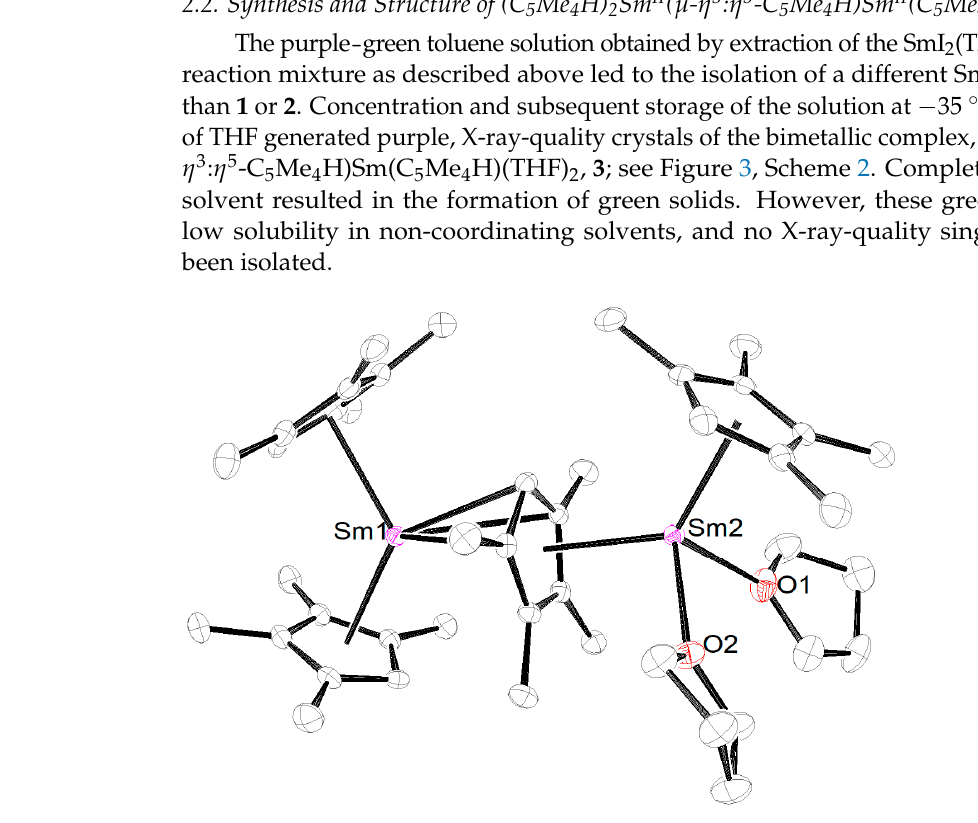
Figure 3. ORTEP representation of complex 3 with selective atom labeling. Ellipsoids are drawn at the 50% probability level. For clarity, hydrogen atoms are not